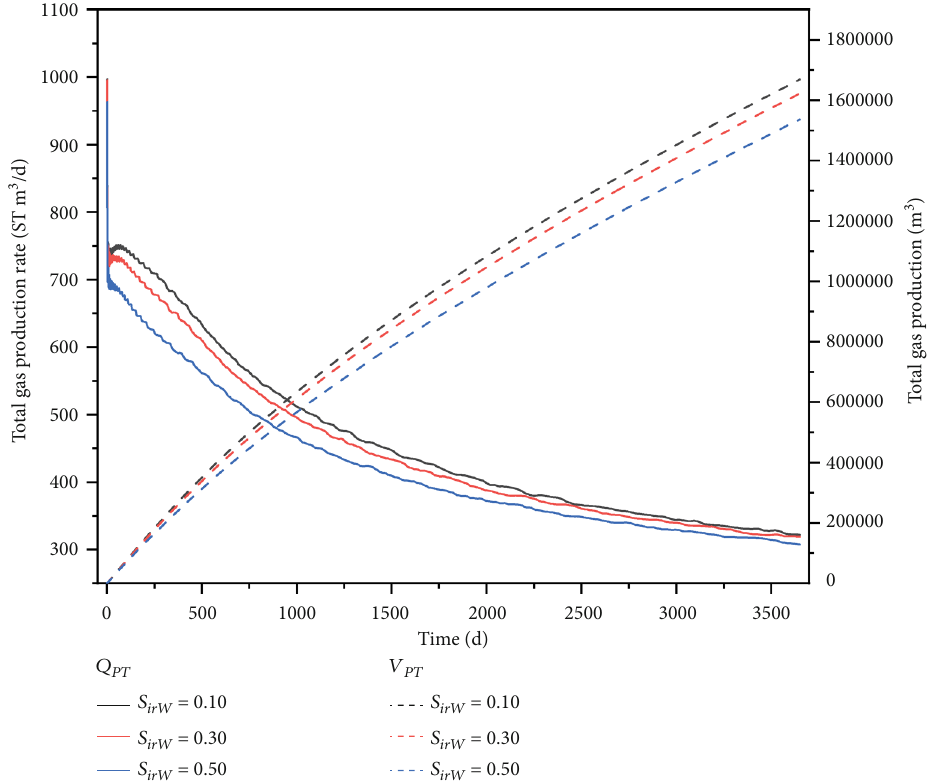
Figure 8: Evolution of total gas production rate Q